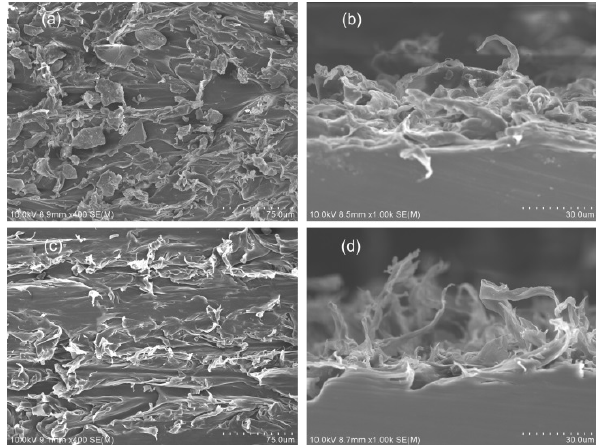
Figure 7: The SEM micrograms of the scraped (a, b), bonded and peeled (c, d) HDPE samples, the left ones are the surface micrograms and the right ones are the cross-section micrograms. The samples were scraped with the abrasive paper P360.